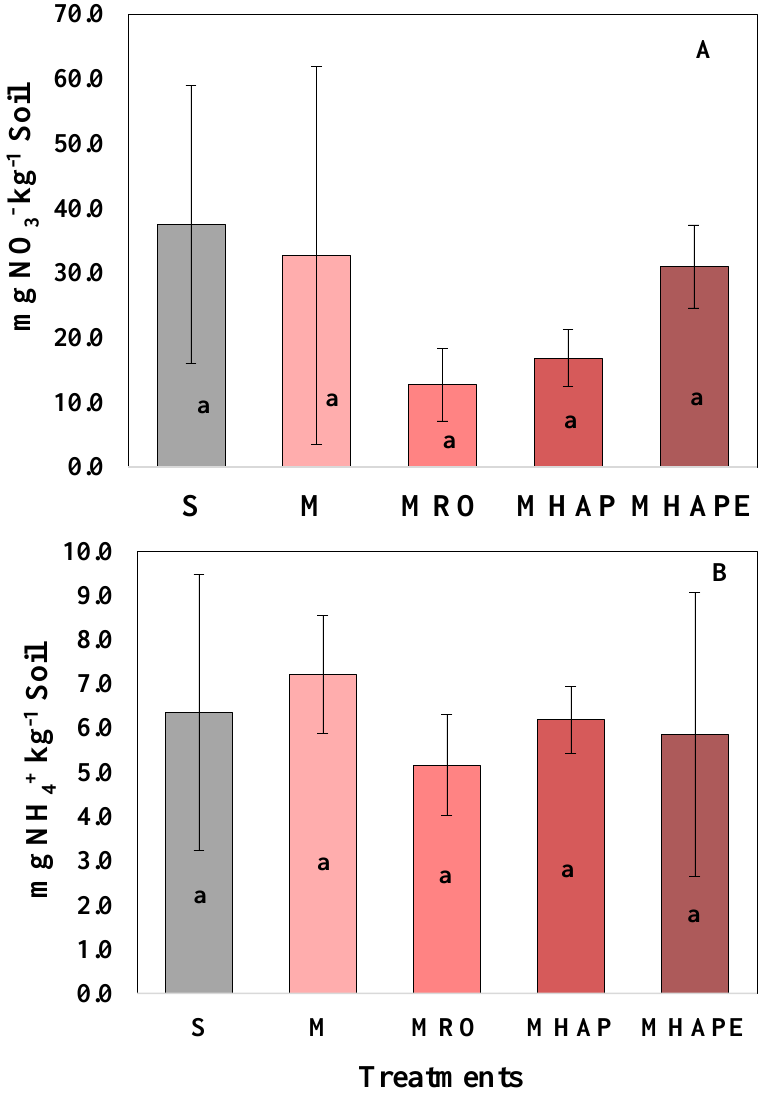
Figure 5. The effect of treatments on soybean soil nitrate-N ( A ) and ammonium-N ( B ) concentrations. The mean was calculated for n = 4; the vertical bar represents the standard deviation of the mean. Here, S = soil control; M = manure control; MRO = manure + red oak biochar; MHAP = manure + highly alkaline porous biochar; MHAPE = manure + corn feedstock autothermal porous Fe-engineered biochar. The means were not statistically different at p < 0.05 level.